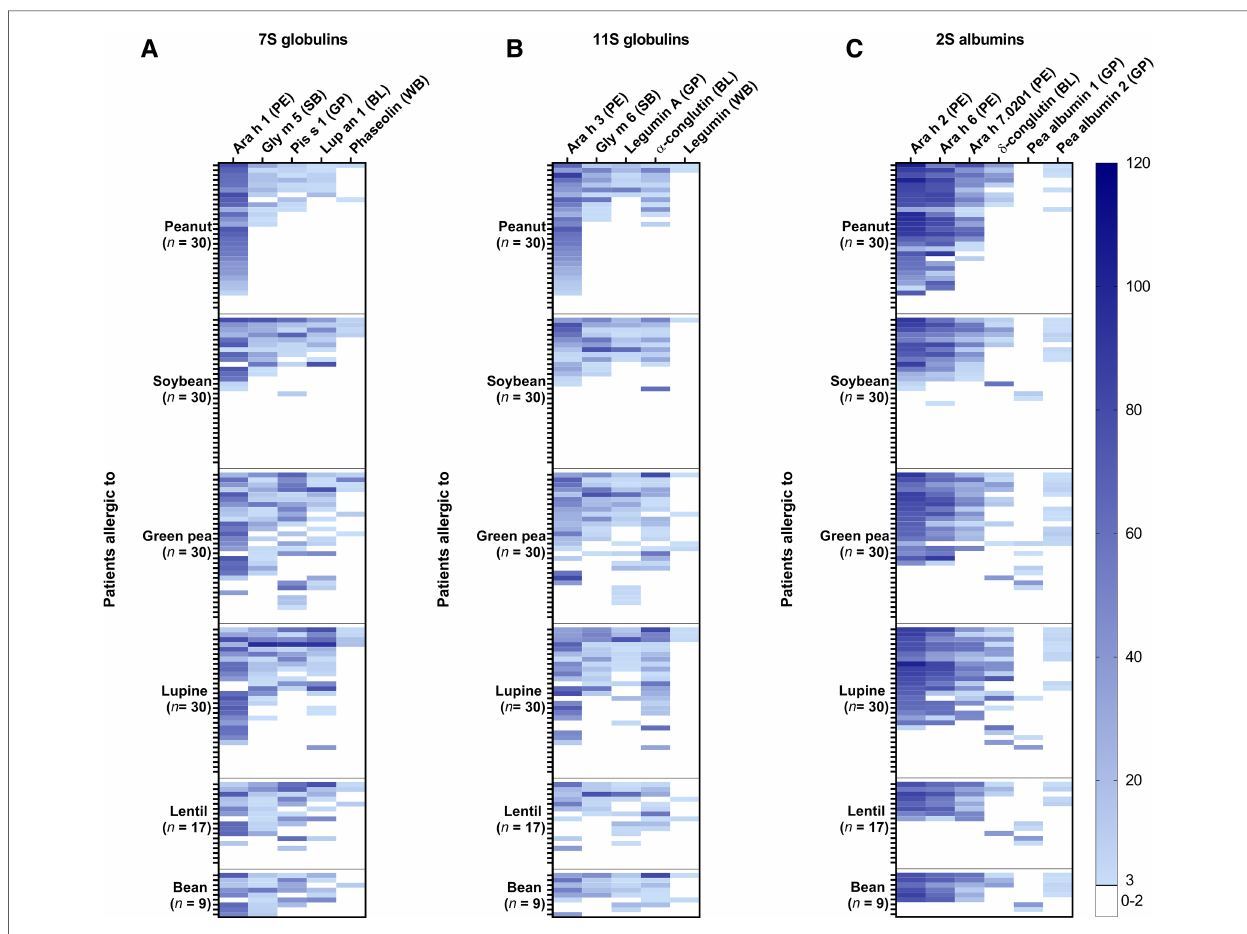
FIGURE 2 The frequency of sensitization for individual proteins from peanut (PE), soybean (SB), green pea (GP), blue lupine (BL), and white bean (WB) in peanut, soy, green pea, lupine, lentil, and bean-allergic patient groups. ( A ) The intensity of IgE binding was shown for individual 7S globulins, ( B ) 11S globulins, ( C ) and 2S albumins. Darker shades of blue indicated a higher intensity of IgE binding and each row represented the same